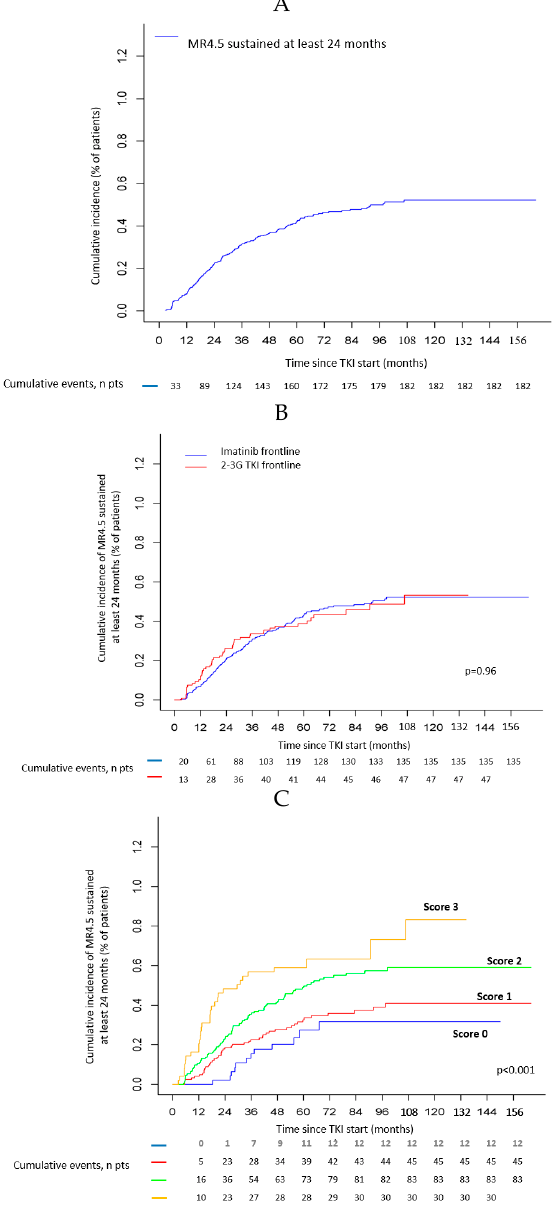
Figure 2. (A): Cumulative incidence of molecular response 4.5 log sustained for at least 24 months (N = 398 patients). (B): Cumulative incidence of sustained molecular response 4.5 log of at least 24 months according to first-line TKIs (Imatinib vs. 2nd or 3rd generation TKI). (C): Cumulative incidences of sustained MR4.5 of at least 24 months according to predictive factors. For each positive factor, female gender, B3A2 BCR-ABL1 transcript type, and low risk ELTS score, one point is scored. The sum of points defined as the number of positive factors (0, 1, 2, or